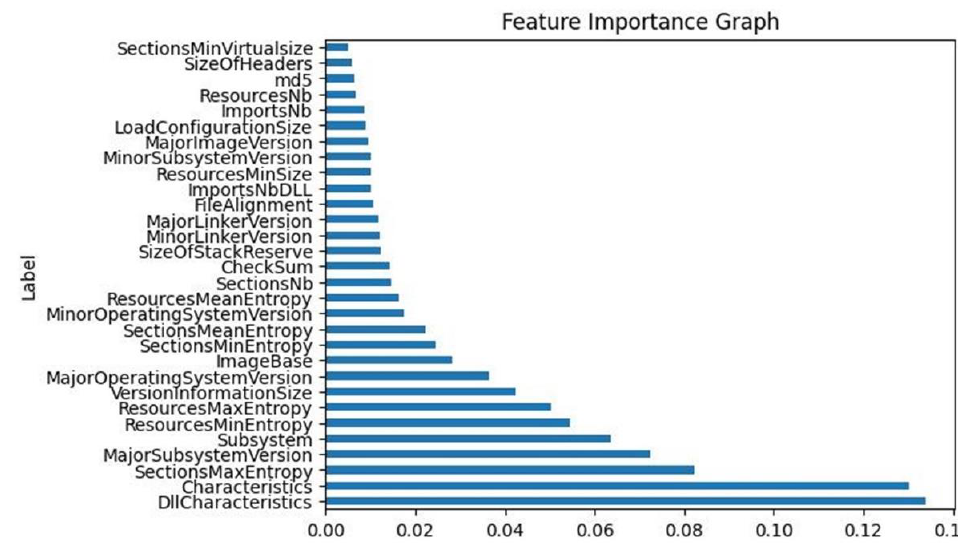
Figure 2. Top 30 features of the initial dataset based on the feature importance.